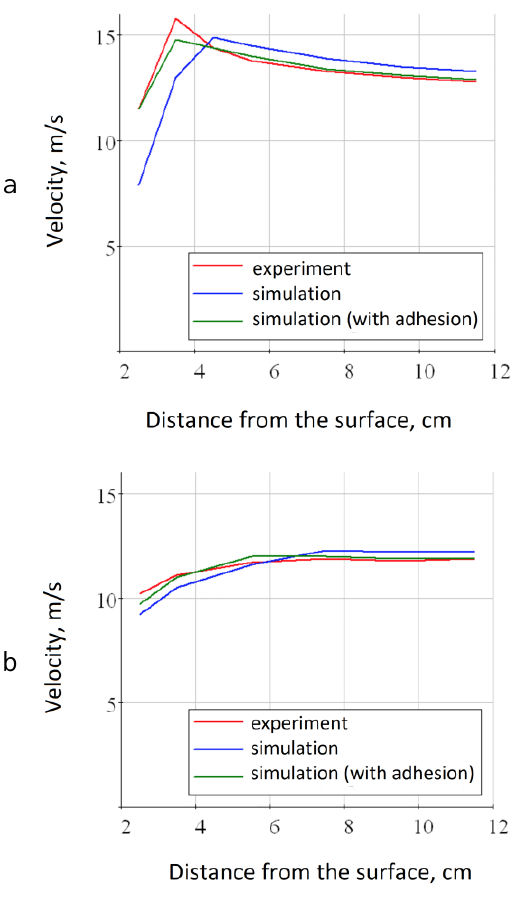
Fig. 8 Time-averaged velocity profiles, calculated from the velocity fields on the first control line in the shielding zone (a) and the second control line in the reattachment zone (b). Positions of control lines are indicated on the Fig.